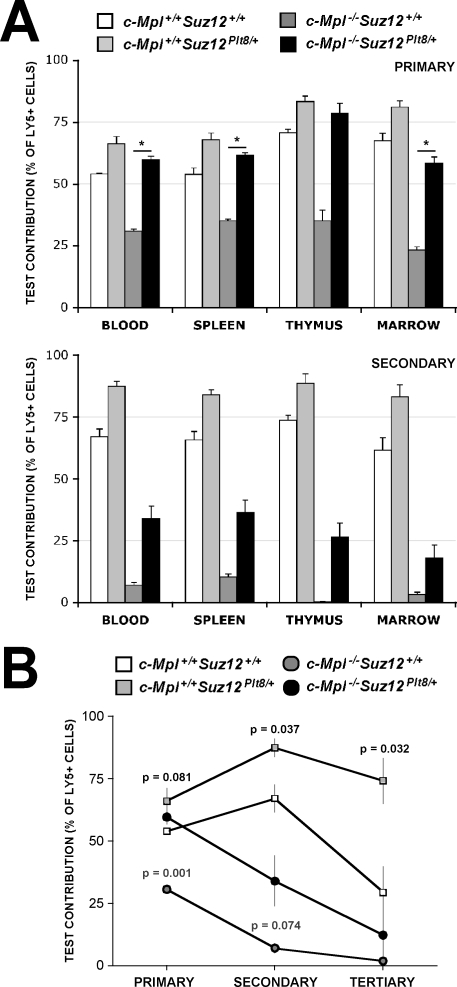
Suz12 Deficiency Enhances HSC Activity in Competitive Transplantation Assays(A) Irradiated recipients (CD45Ly5.1) were transplanted with an equal number of bone marrow cells from a test animal (CD45Ly5.2, either Suz12Plt8/+ or Suz12+/+) and a wild-type competitor (CD45Ly5.1, Suz12+/+, and equivalent Mpl genotype). Peripheral blood and other tissues were collected and stained with antibodies to CD45Ly5.1, CD45Ly5.2, and various lineage markers to measure the contribution of the test marrow to hematopoiesis. Suz12Plt8/+ cells made a greater contribution than competitor cells (Suz12+/+) on both a c-Mpl+/+ and a c-Mpl–/– background. Serial transplantation was performed at 12–20 wk. Primary (top panel) and secondary recipients (bottom panel) were analysed 3 mo after transplantation. Each column is the average of 3–4 test marrows transplanted into 5 recipients. An asterisk denotes statistical significance (p < 0.004) corrected for multiple testing.(B) The representation of Ly5.2+ test cells in the peripheral blood is plotted in primary, secondary, and tertiary recipients. Comparisons were made between mice with matched c-Mpl genotypes (p-values are shown in gray for c-Mpl–/– and in black for c-Mpl+/+).